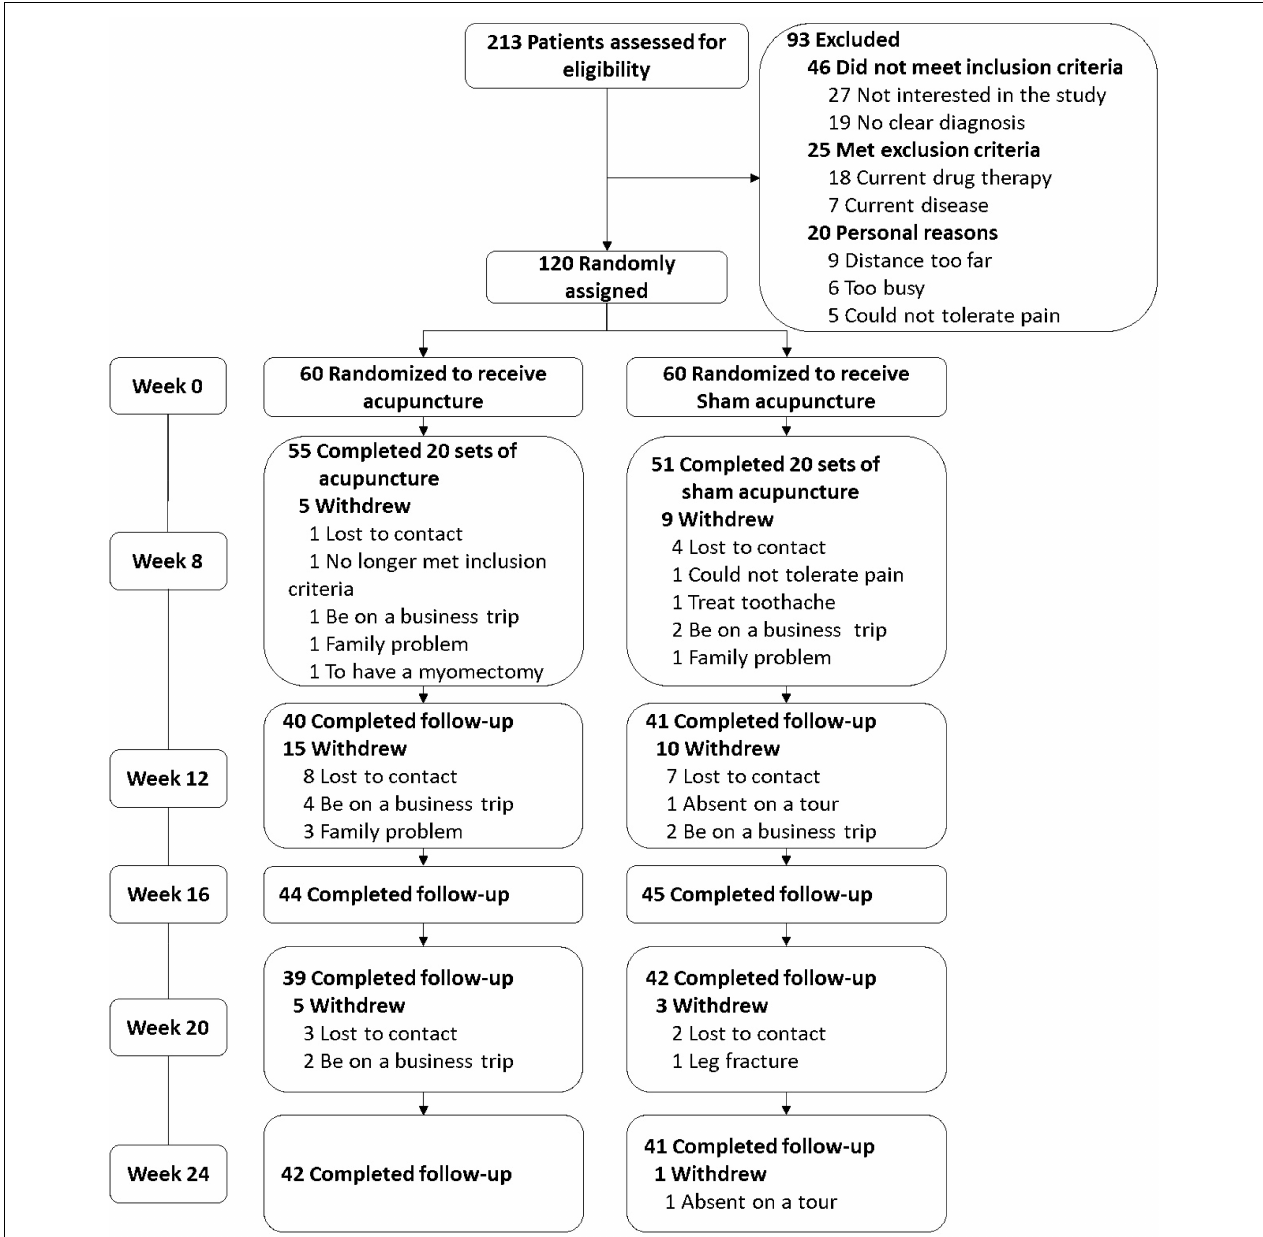
FIGURE 1 | Study flow. The NAS scores at week 0 were was set as baseline of primary outcome. 70.0% (42/60) of the patients received acupuncture between weeks 0 and 8 and then were successfully followed up between weeks 8 and 24, 68.3% (41/60) in the sham